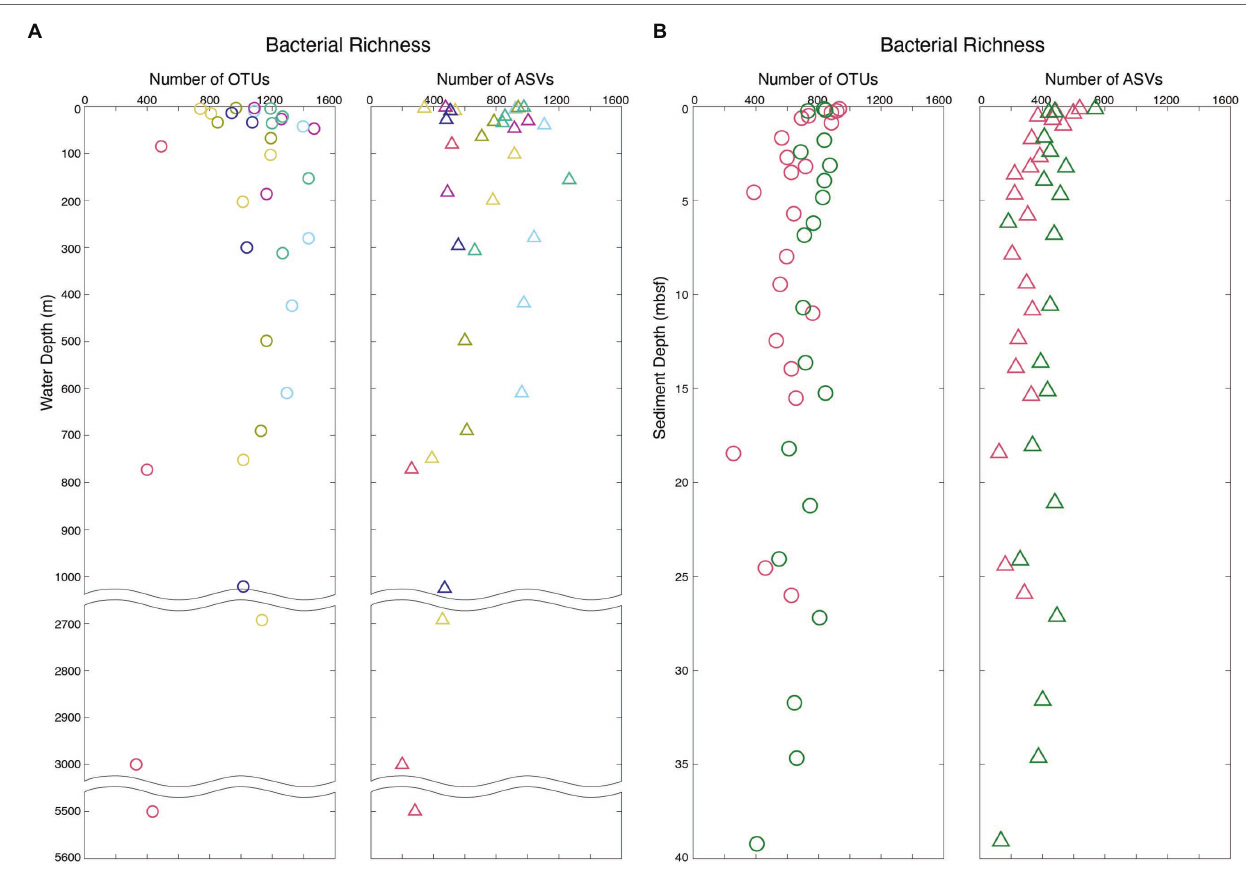
FIGURE 2 | Bacterial richness profiles of the water column and marine sediment analyzed with both OTU- and ASV-based methods. All Arctic sample sites exhibit similar profiles, and only four of the nine Arctic sites are presented here for ease of visualization. Sample colors correspond to sample sites plotted in Figure 1 . (A) Bacterial richness of water column OTUs (right) and ASVs (left). (B) Bacterial richness of marine sediment OTUs (right) and ASVs